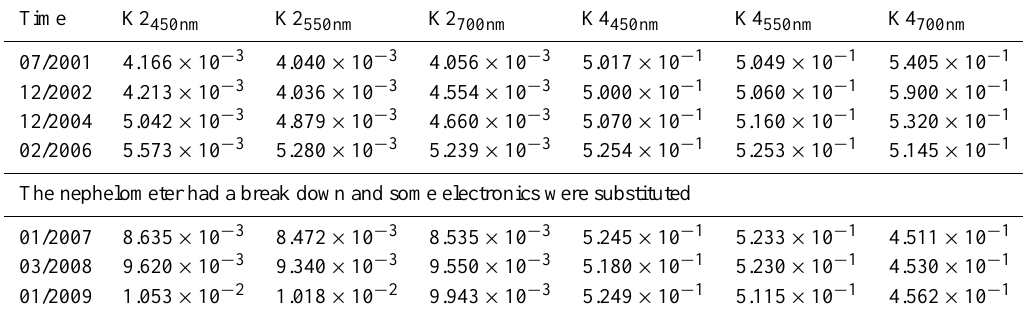
Table 1. Time evolution of the calibration constants, K2 and K4 (m − 1 ) , at three wavelengths. Time K2